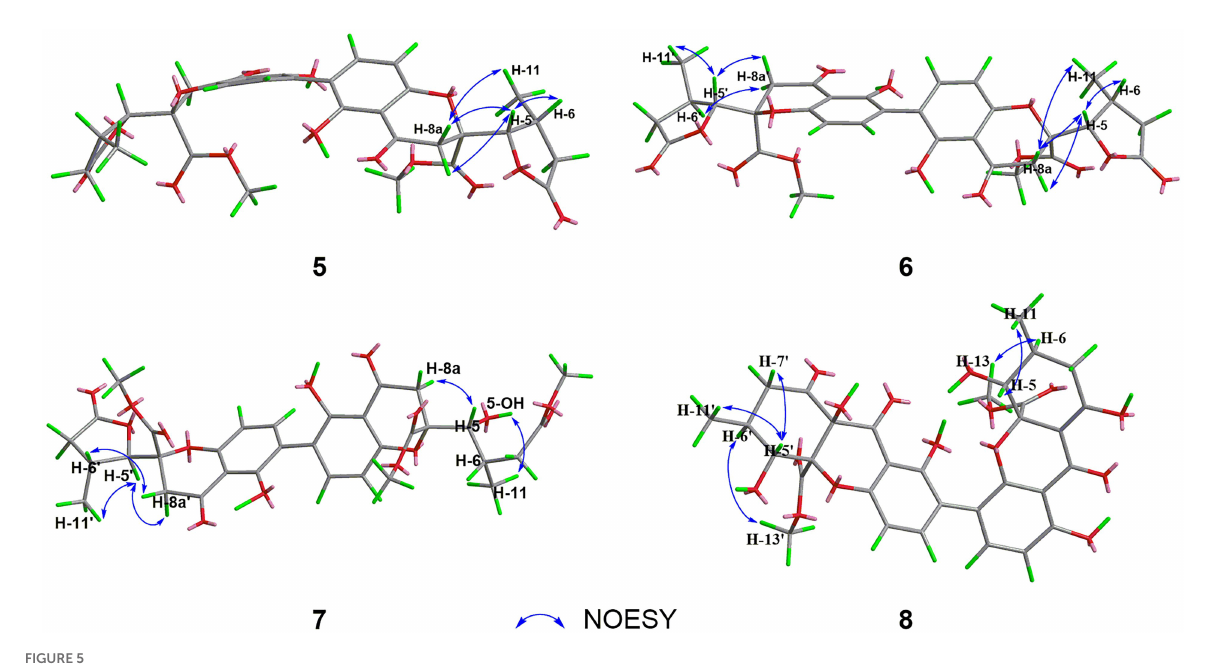
FIGURE 5 NOESY correlations of 5 – 8 .